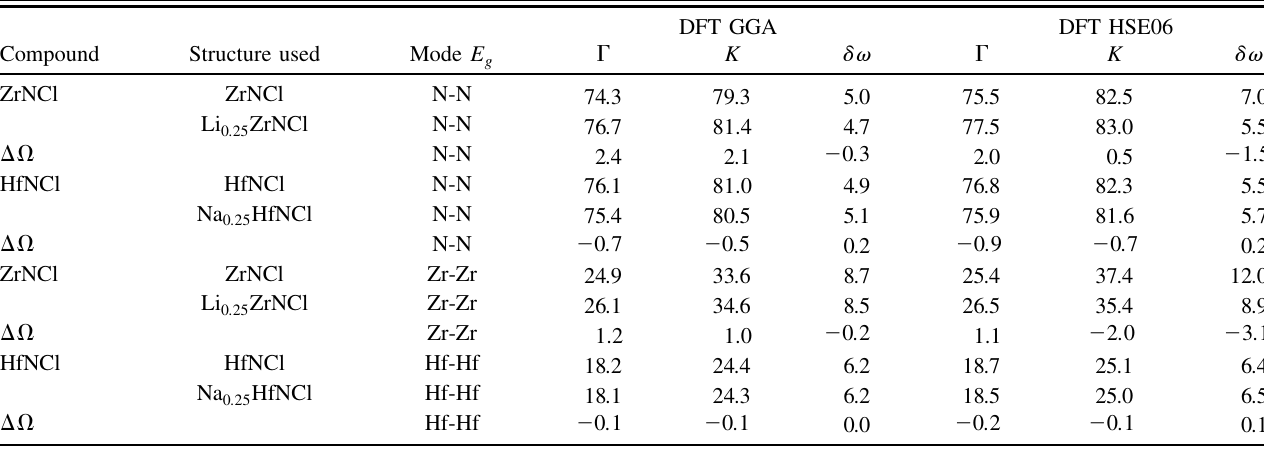
TABLE V. Phonon frequencies of the E mode at zone-center (cid:2) point and zone-boundary K point in ZrNCl and HfNCl compounds g with structures with and without electron doping calculated by frozen-phonon calculations in the DFT GGA and DFT HSE06 framework. Notice that upon electron doping, the changes in the crystal structure do not cause substantial changes in the phonon frequencies. Therefore, the phonon softening shown in Table IV is electronic in origin rather than structural. DFT GGA DFT HSE06